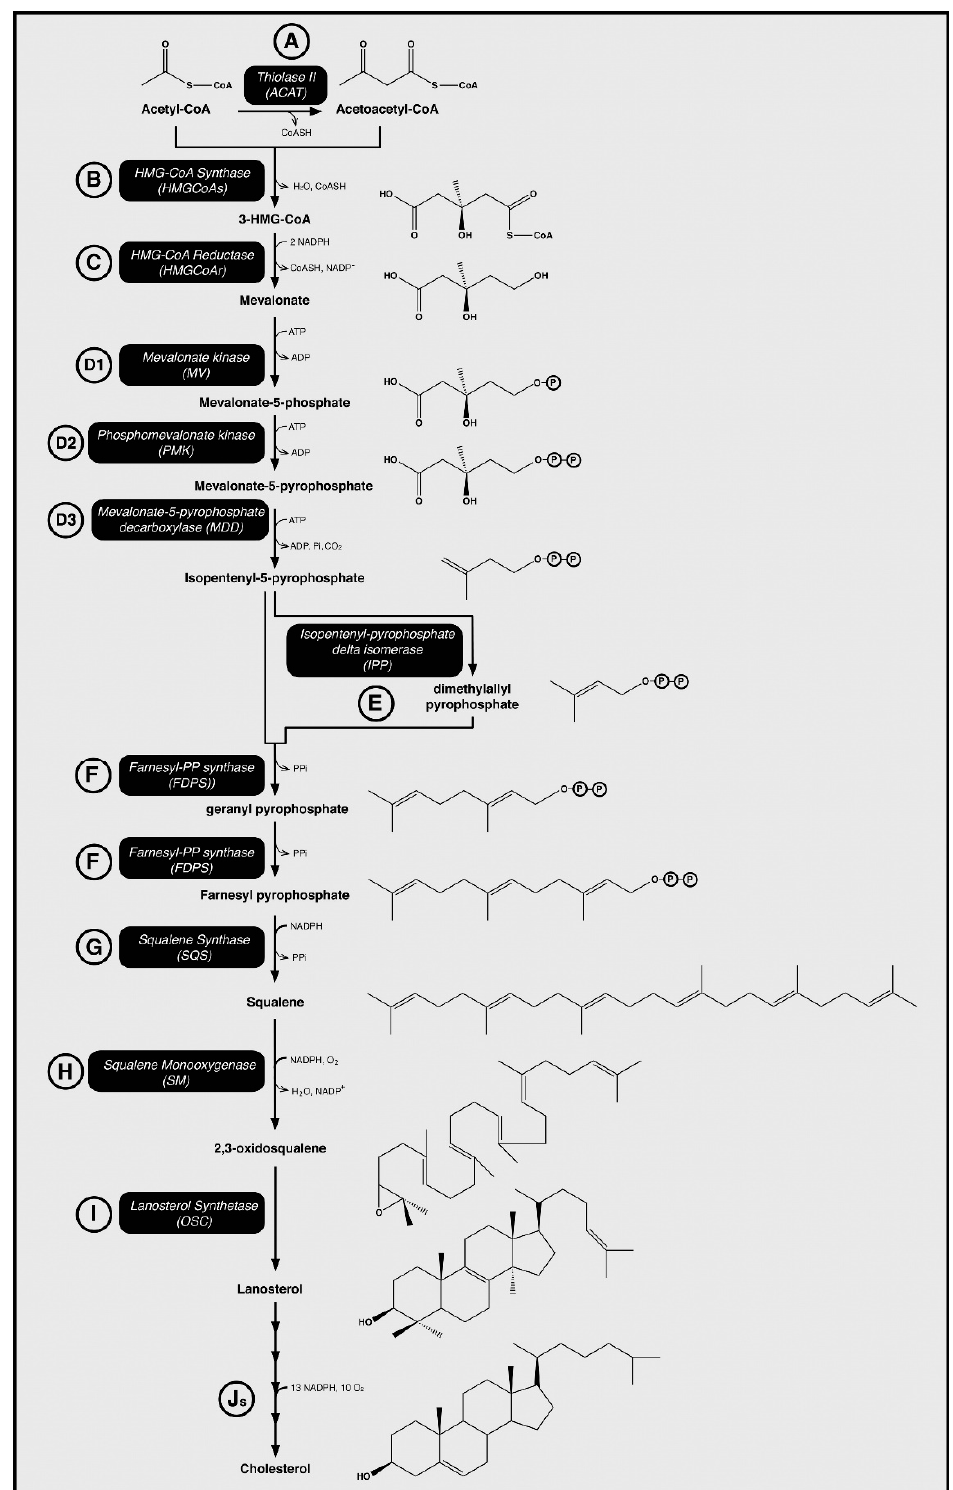
Figure 1. The cholesterol biosynthesis pathway and enzymes involved. Enzymes are labelled with letters in alphabetical order and referred to within the text; “s” indicates more than one enzyme in the step. Reprinted with permission from Cerqueira et al., Cholesterol Biosynthesis: A Mechanistic Overview, Biochemistry 55 (2016) 5483–5506 [16]. Copyright (2016) American Chemical Society.